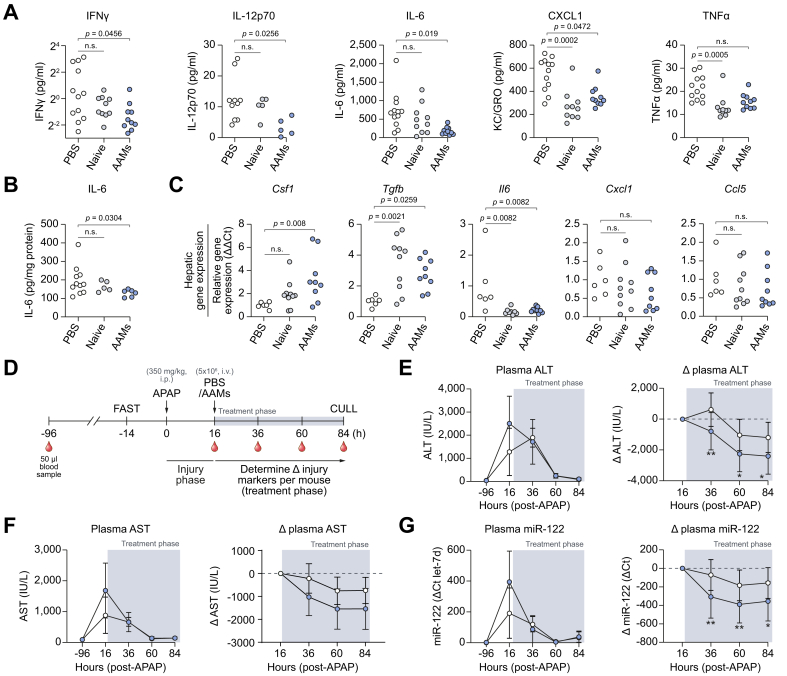
Injection of AAMs reduces several serum proinflammatory cytokines following APAP-ALI.(A) Serum concentrations of proinflammatory cytokines measured in APAP-ALI mice receiving indicated treatments (n = 10–12 per group; some sera had undetectable IL-12p70). (B) IL-6 levels in liver homogenates from APAP-ALI mice receiving indicated treatments (n = 5–11 per group) (C) Relative expression of indicated genes (using 2−ΔΔCT method; standardised to PBS-treated controls, after GAPDH normalisation) in liver tissue of APAP-ALI mice receiving indicated treatments (n = 6–10 per group). In A–C, white circles — individual vehicle controls; grey circles — cell-transfer reference group; blue circles — AAM-treated mice. (D) Study design: Plasma biomarkers were measured daily in APAP-ALI mice following PBS/AAM-treatment. (E/F/G) Plasma biomarkers (left panels) and change in plasma biomarkers from point-of-treatment (right panels) for plasma ALT activity (E), AST activity (F), and miR-122 levels (G). Shaded area represents treatment phase. Grouped values represents mean ± SD for AAM-treatment (blue) and PBS-treatment (white). Plasma miR-122 levels are presented as relative quantitation (using 2-ΔΔCT method; standardised to pre-APAP-ALI levels (−96 h), after let-7d normalisation). p values provided in panels; n.s., not significant, ∗p <0.05, ∗∗p <0.01. Kruskal-Wallis tests for A/B/C (Csf1/Ccl5), one-way ANOVA for C (Tgfb, Il6, Cxcl1), mixed-effects model for (E/F/G). AAMs, alternatively activated macrophages; ALI, acute liver injury; ALT, alanine aminotransferase; APAP, acetaminophen; APAP-ALI, APAP-induced ALI.